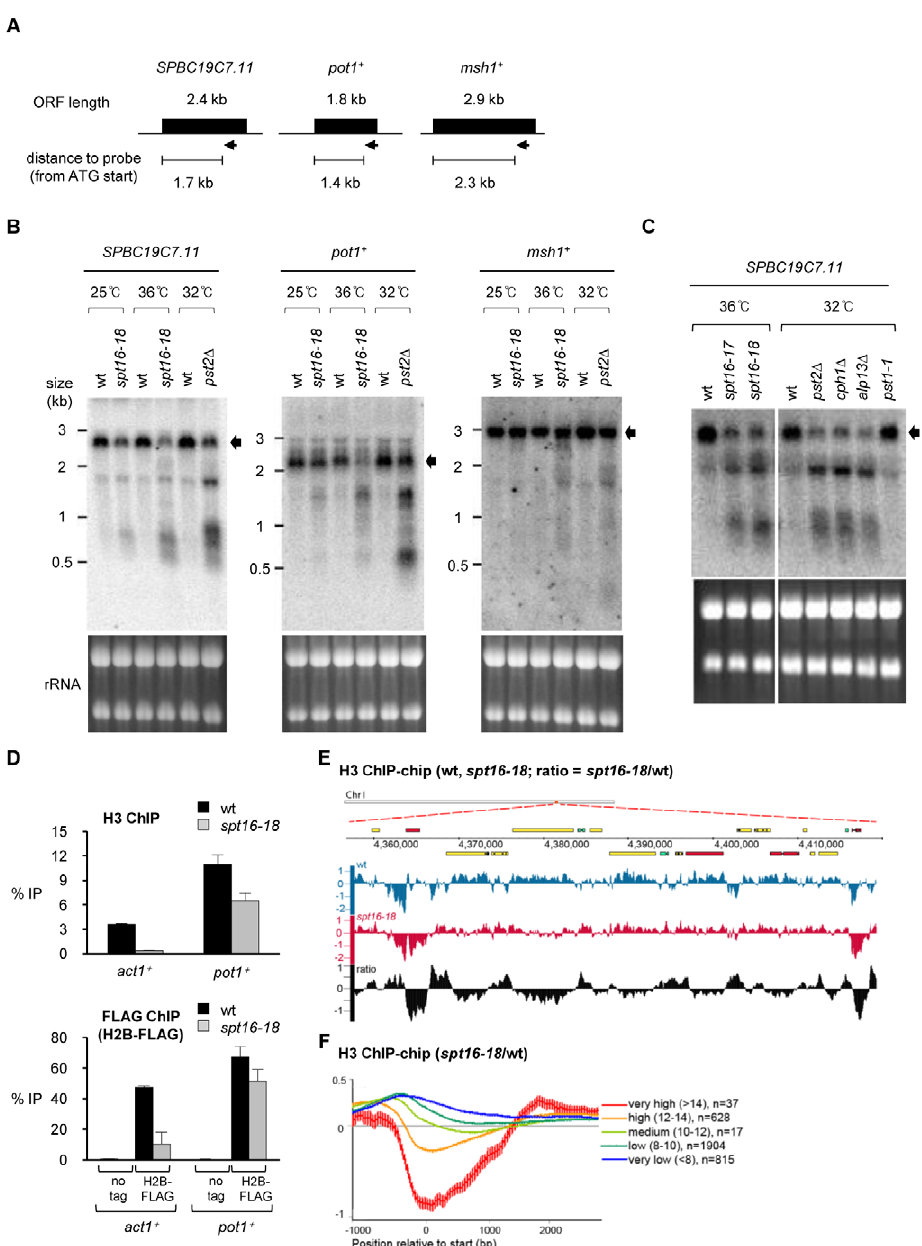
Figure 2. Spt16 is required to suppress cryptic transcription initiation and nucleosome loss at RNAPII genes. (A) Schematic of genes and positions of RNA probes (arrow) used in Northern analysis. (B) Northern analyses of transcripts from SPBC19C7.11 , pot1 + and msh1 + genes. RNA was extracted from cells grown at 25 u C (wt, spt16-18 ), 32 u C for 6 h (wt, pst2 D ) or 36 u C for 1 h (wt, spt16-18 ) after shift from 25 u C. Arrow indicates full- length transcripts. (C) Northern analysis of transcripts from SPBC19C7.11 . Cells were grown at 36 u C for 2 h after shift from 25 u C (wt, spt16-ts ) or at 32 u C for 6 h after shift from 25 u C (wt, pst2 D , cph1 D , alp13 D , pst1-1 ), as indicated. (D) ChIP analysis of H3 levels at act1 + and pot1 + in wt and spt16-18 cells grown at 36 u C for 1 h after shift from 25 u C (top). ChIP analysis of H2B levels at act1 + and pot1 + in wt and spt16-18 cells expressing H2B-FLAG or untagged H2B (bottom). Enrichment is reported as % IP. Error bar indicates S.D. from 3 biological replicates. (E) Genome browser view showing ChIP- chip occupancy profiles for H3 in wt (blue) and spt16-18 cells (red). The relative ratio ( spt16-18 /wt) is indicated in black. Data on the Y-axis are presented in log2 scale and the X-axis shows genome positions in base pairs. Open reading frames (ORFs) are displayed as boxes and colored according to transcription levels (highly transcribed genes in red, medium transcribed genes in green and low transcribed genes in blue). (F) Average gene analysis for the ratio of H3 occupancy in spt16-18 mutants versus wt. Genes are aligned at transcription start site and divided into four groups dependent of their transcription levels. Data on the Y-axis are presented in log2 scale and the X-axis shows position relative to start (bp). Values for gene expression were calculated using Podbat based on the RNA data from a previous study [61,62]. The gene expression value ranged between 5 and 15, and genes were assigned into categories based on this value. Five categories were made: very high ( . 14) (n=37), high (12–14) (n=591), medium (10–12) (n=1726), low (8–10) (n=1904) and very low ( , 8) (n=815). n=number of genes in each group. Error bars represent 99% confidence intervals.